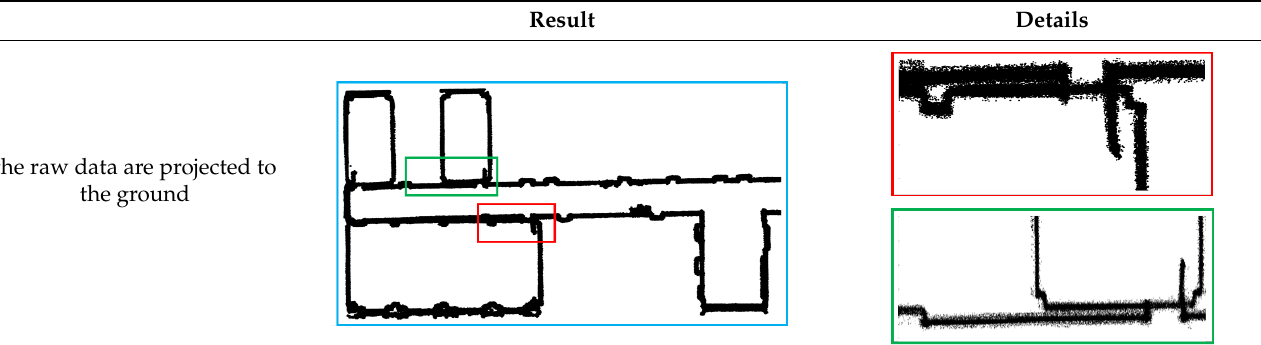
Figure 9. The process of converting grid points to the image: the pixel corresponding to the positions of the grid points in the image is given the value . The image is made up of pixels in the red box in the final step. Table 2. Projection and transformation of data. First, the raw data are projected onto the ground plane. Then, the noise is removed by the GROR filter. We enlarge the coordinates 70 times and the grid subsampling method is used to make the data regular. The regular data can be converted to an image, which is prepared for the next section. Result Details